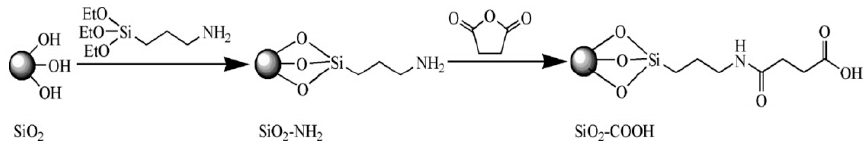
Figure 2. Surface modification mechanism of CdTe/SiO 2 fluorescent nanoparticles.